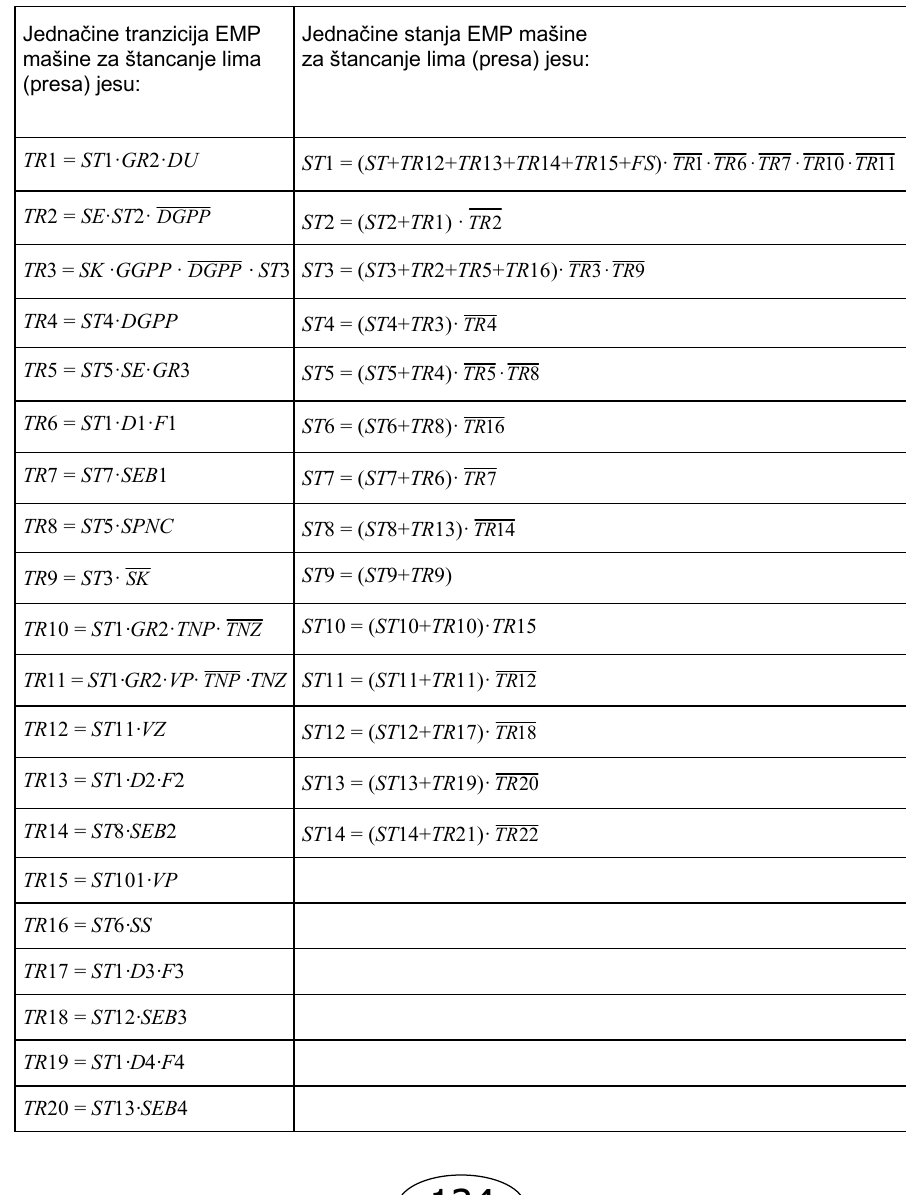
Table 6 – Equations of state and transitions and EMP machines for sheet metal stamping Jedna č ine tranzicija EMP Jedna č ine stanja EMP mašine mašine za štancanje lima za štancanje lima (presa) (presa) jesu: